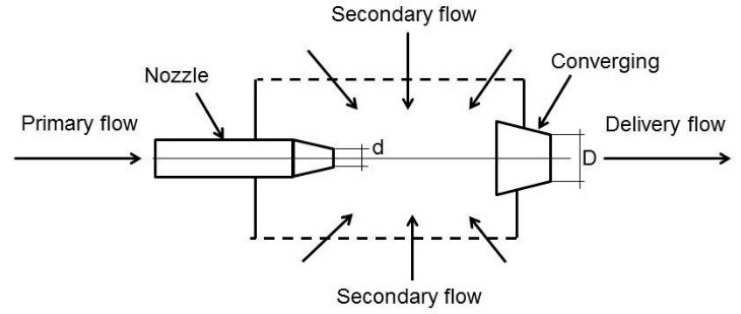
Figure 3. Sketch of the ejector, reproduced from [14].